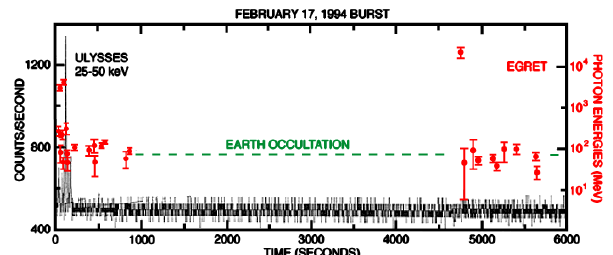
Figure 1. EGRET light curve for the GRB 940217 with the detection of an ∼ 18 GeV photon that occurred about 90 min after the GRB onset. From https://fermi.gsfc.nasa.gov/science/resources/ docs/vwp/. Available online: (accessed on 10 April